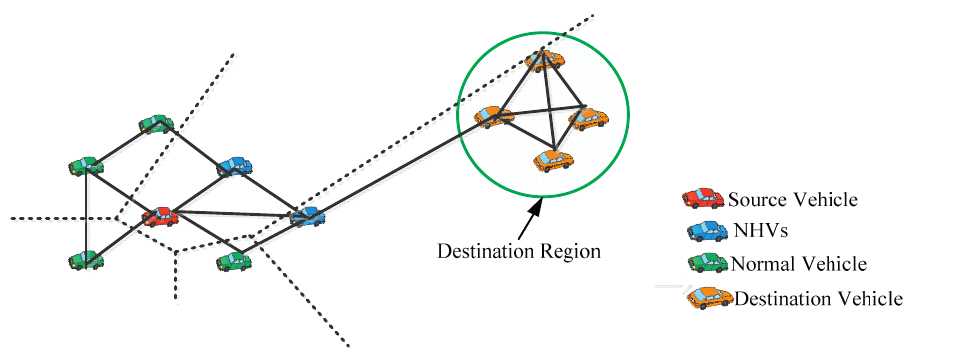
Figure 2. NHVs selection using